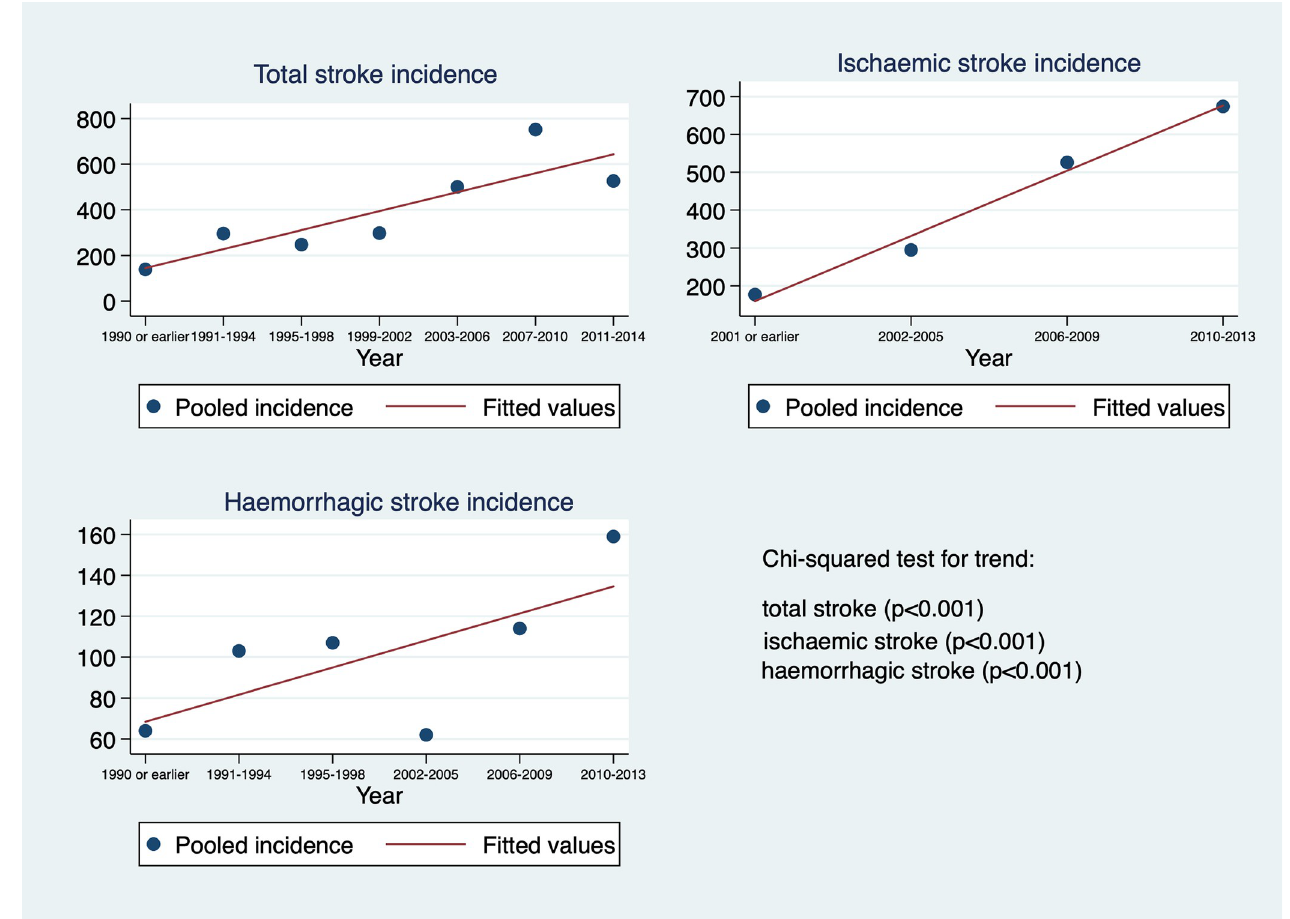
Fig 3. Scatter plots of stroke incidence by median study